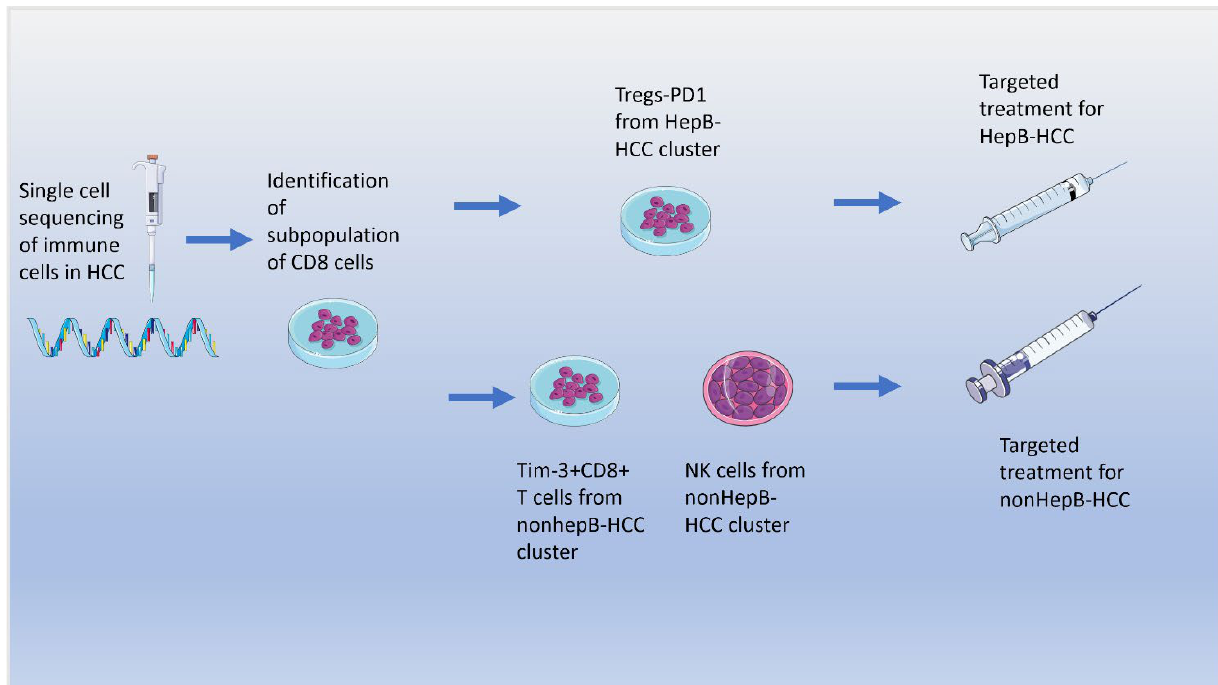
Figure 5. Schematic depiction of single cell technology and how it can potentially be used for targeted, individualized treatment of HCC based on immune cell, and HCC risk factor phenotype.